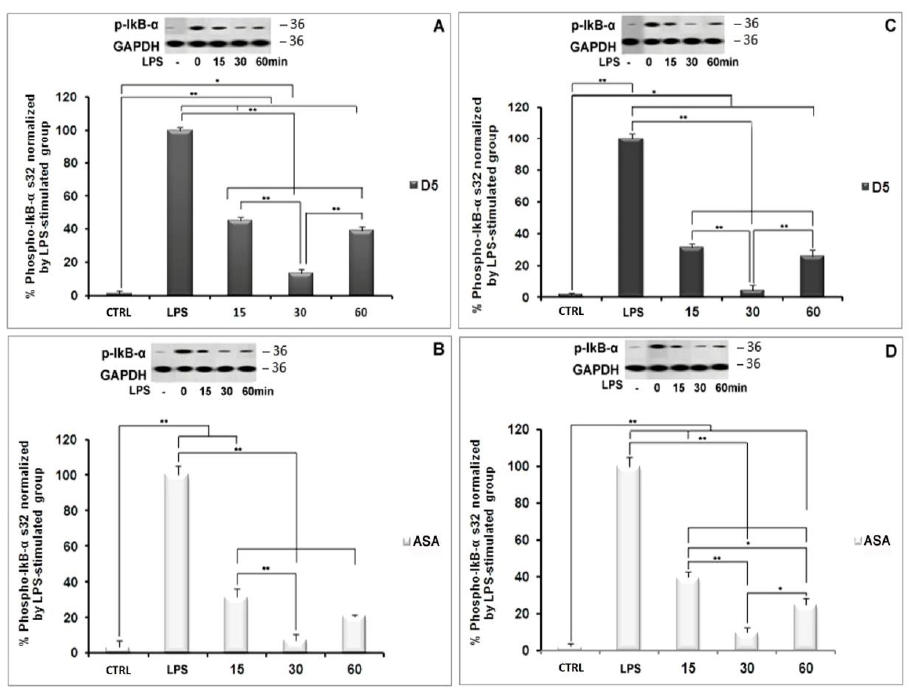
Figure 7. NF- κ B silencing using D5 treatment of LPS-Stimulated astrocyte ( SVG ) and microglia ( CHME3 ) cell lines. Astrocytic glial (SVG) and microglial (CHME3) cells were pretreated with D5 ( A , C , respectively) and ASA ( B , D , respectively) for 24 h before LPS stimulation (100 ng/mL) at the indicated time points (0 (LPS), 15, 30, and 60 min). Total cellular proteins were extracted and I κ B- α (phospho-I κ B- α S32) protein levels in SVG and CHME3 cells were estimated to investigate LPS- induced NF- κ B activation in the cytosol of glial cells using Western blot analysis. Optical densities of individual protein bands were normalized to the corresponding levels of GAPDH. The figures represent the best protein bands and their quantitative analyses. Groups were compared using the percentages of the positive control groups of both cell lines at time 0 (drug-untreated LPS-stimulated cells). Data are presented as the mean ± S.D. of four samples in one independent experiment. The data were replicated in three repeated independent experiments. * p < 0.05; ** p < 0.01